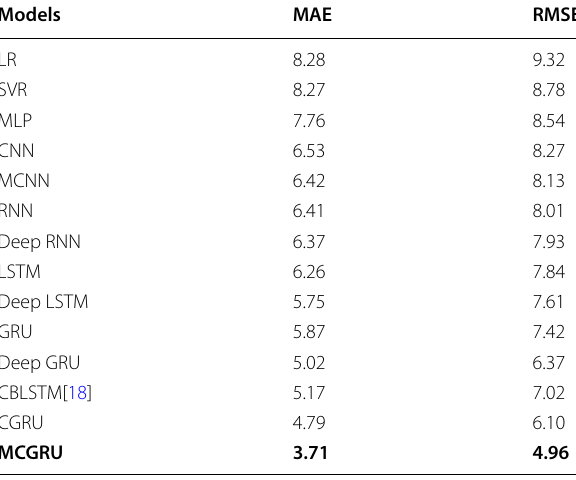
Bold face indicates the best performance Table 7 MAE and RMSE of all the models in the second experimental case